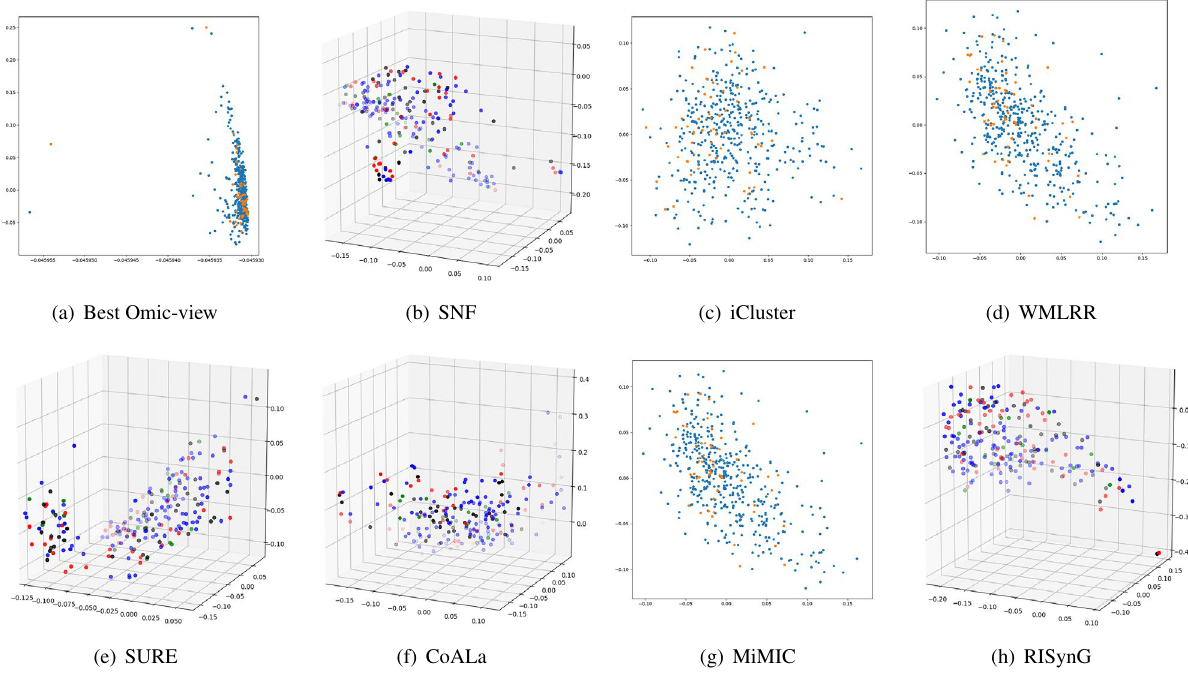
Figure 5. Comparative analysis of different integrative sub-spaces on OV dataset.